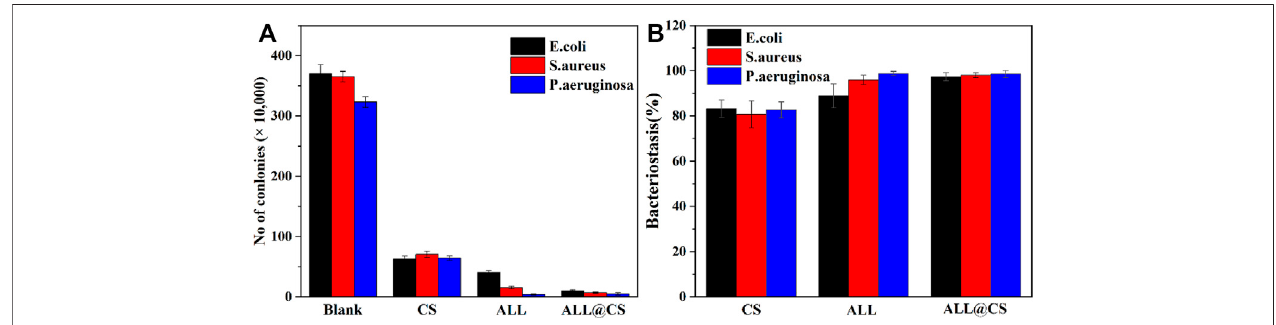
FIGURE 3 | Number of E. coli , S. aureus , and P. aeruginosa colonies in LB and 2216E medium for 18 h with pure CS, ALL, and ALL@CS nanocapsules (A) . The bacteriostasis of these three different bacteria strains corresponding to each counting result (B) .